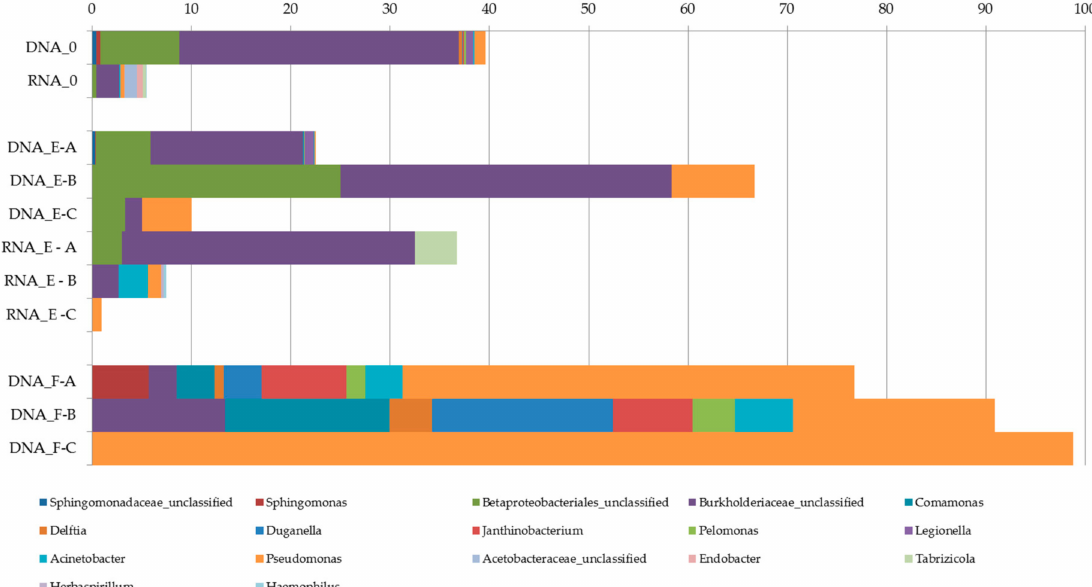
Figure 5. Burkholderiaceae and Pseudomonadaceae OTU taxononomy at genus level based on bacterial 16S rRNA gene. First are the samples representing the original fracture fluid: DNA_0 and RNA_0 followed by the enriched samples representing the communities in the incubated microcosms: DNA_E—samples A, B, C (DNA) and RNA_E—samples A, B, C (RNA). At the bottom are the labelled DNA_F—samples A, B, C (DNA-SIP). The used cut-off value for this illustration was ≥ 6 sequences/